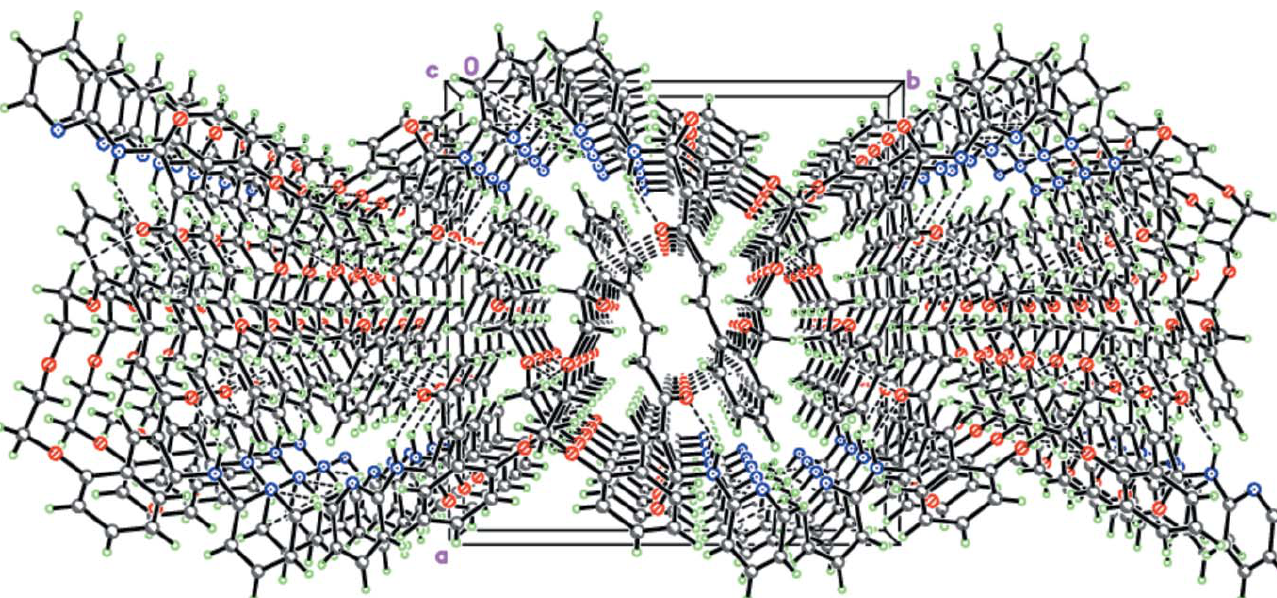
Figure 3 Crystal packing of ( 3) illustrating the two-tier puckered layer parallel to (100). Dashed lines indicate the intramolecular N—H (cid:2)(cid:2)(cid:2) O and the intermolecular C—H (cid:2)(cid:2)(cid:2) (cid:3) and C—H (cid:2)(cid:2)(cid:2) O hydrogen